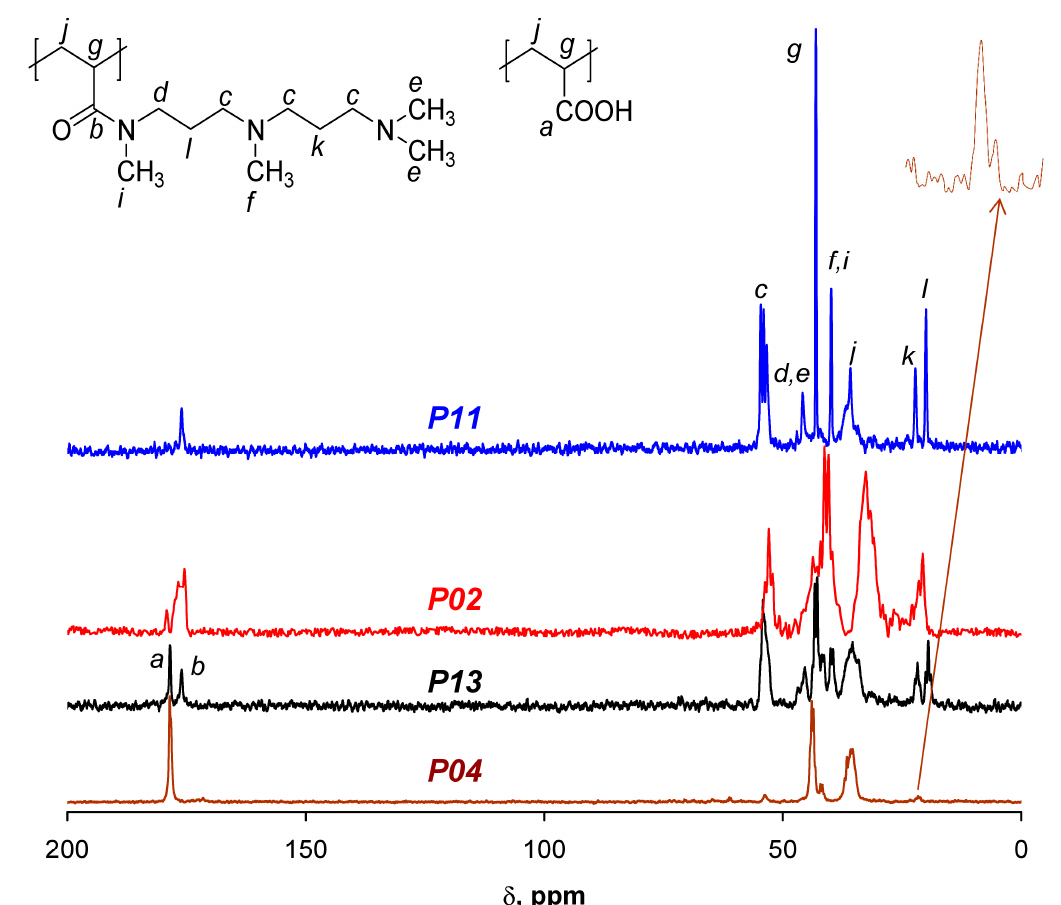
Figure 3. Typical 13 C NMR spectra of polymeric amine (P11) and ampholytes (P02, P13, and P04) obtained by the reaction between poly (acryloyl chloride) and polyamine.